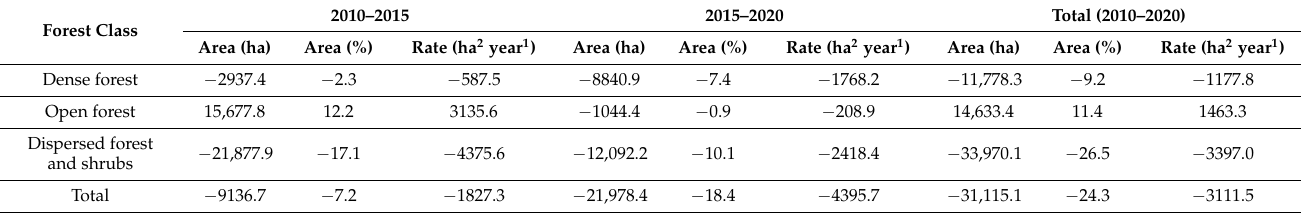
Table 9. Change trend of forest cover by density and the gain–loss rate in the Syrian coast region from 2010 to 2020 (after computing adjusted area